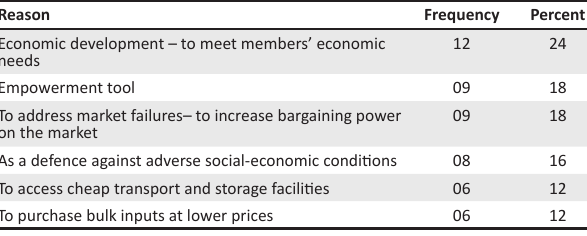
TABLE 2: Reasons for establishing cooperatives.